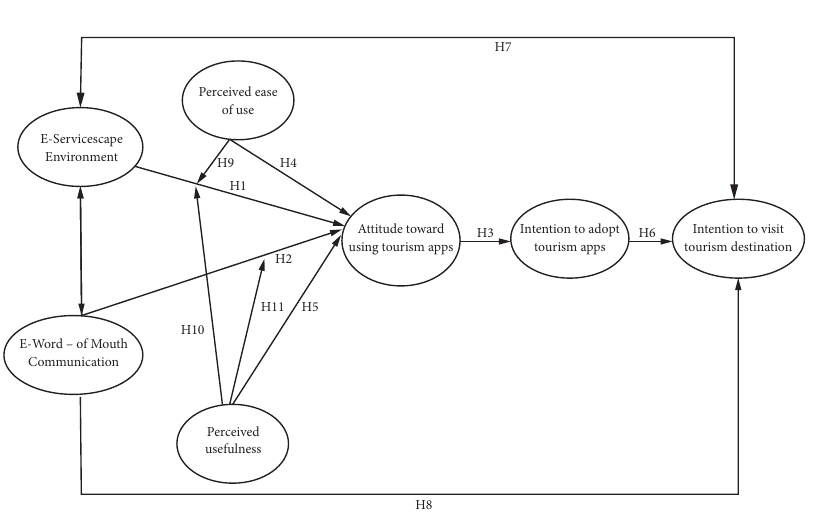
Figure 1. Research